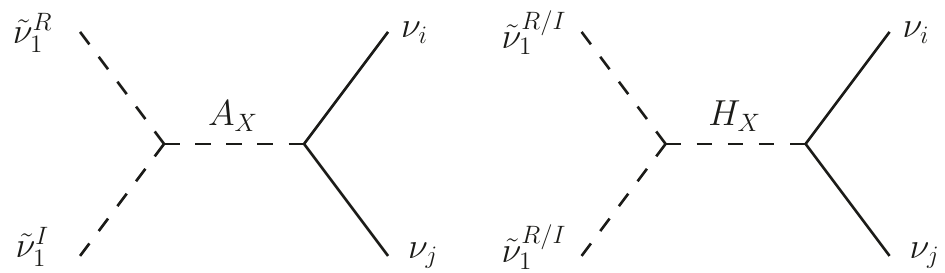
is an annihilation channel. In this subsection, we (cid:12)rst present the co-annihilation via the A X -funnel (scenario A) and then discuss why the annihilation via the H X -funnel (scenario H) is phenomenologically not